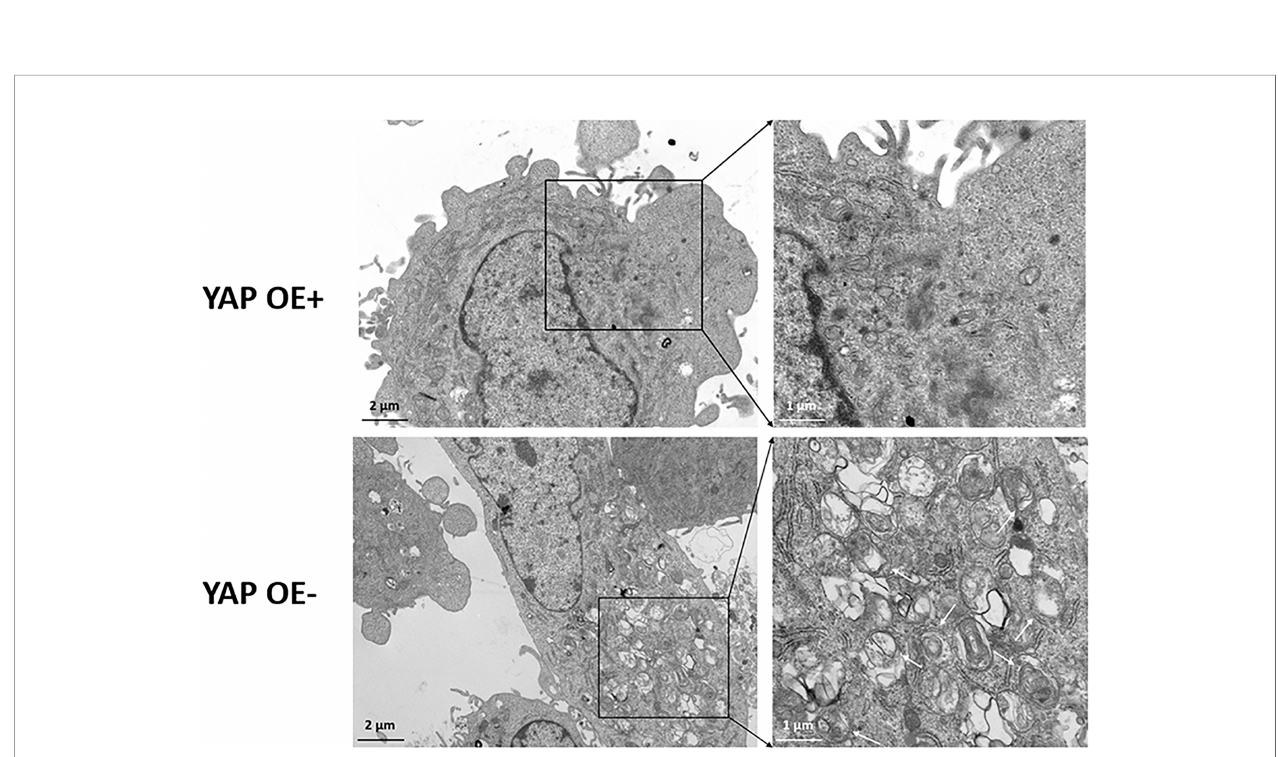
FIGURE 5 | Transmission electron microscope (TEM) observation of autophagosomes after overexpression of YAP in the eutopic ESCs of endometriosis. TEM observation showed the fewer autophagosomes in the YAP-OE group compared with the control